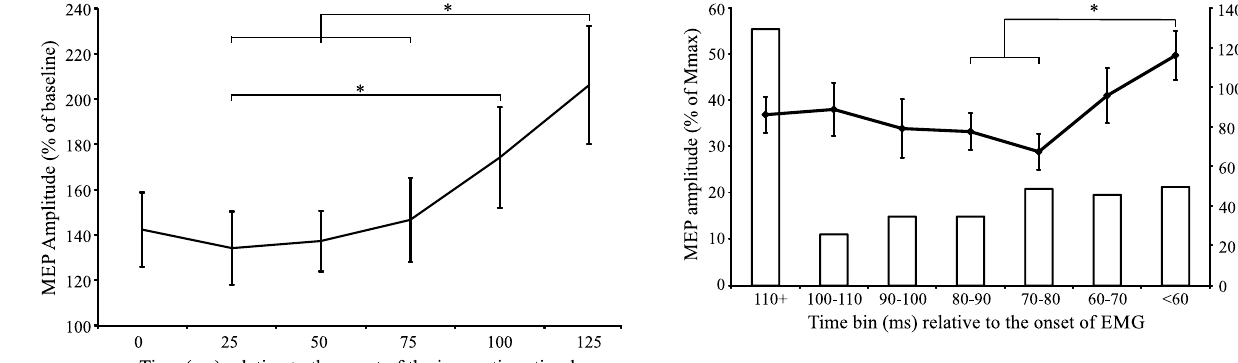
Figure 6. Mean ( + / 2 SE) motor-evoked potential (MEP) amplitude during the RT interval expressed as a percentage of maximal MEP (Mmax) for 10 ms time bins prior to EMG onset. The number of trials making up the mean for each of the time points (secondary axis) is represented by columns. The asterisk (*) denotes a significant increase in MEP amplitude as EMG onset approaches.